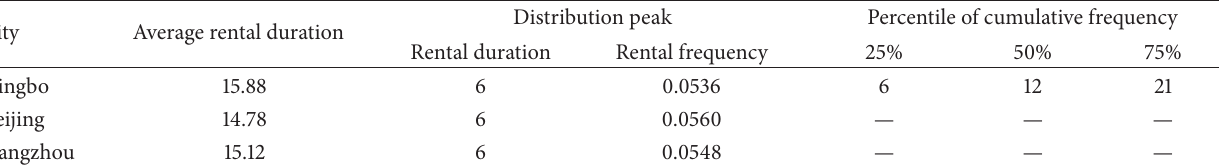
Table 3: Characteristics of public bicycle rental duration for the three cities.